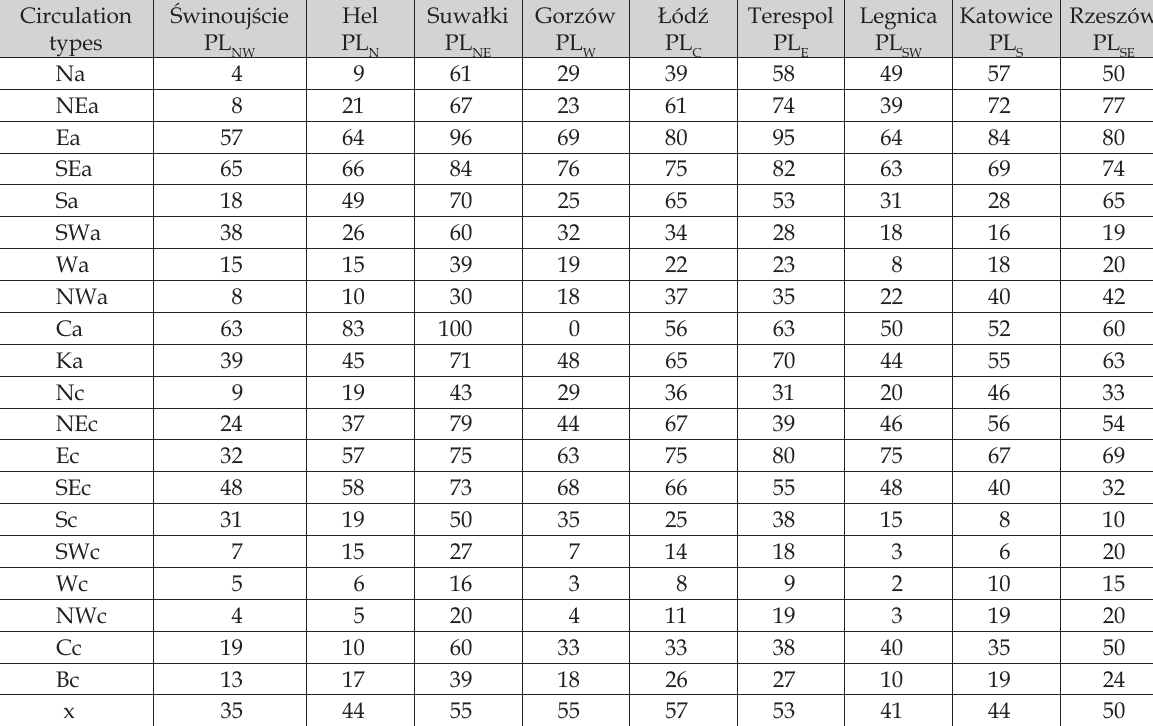
Table 3. Conditional probability of the ice days occurrence in circulation types at stations representing each grid box for which circulation classification